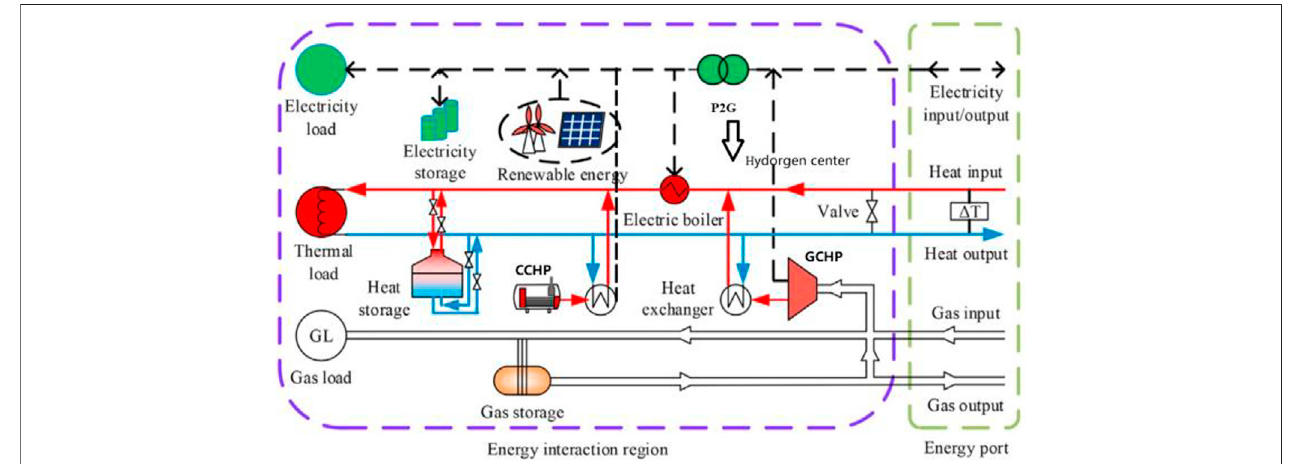
FIGURE 12 | We-energy